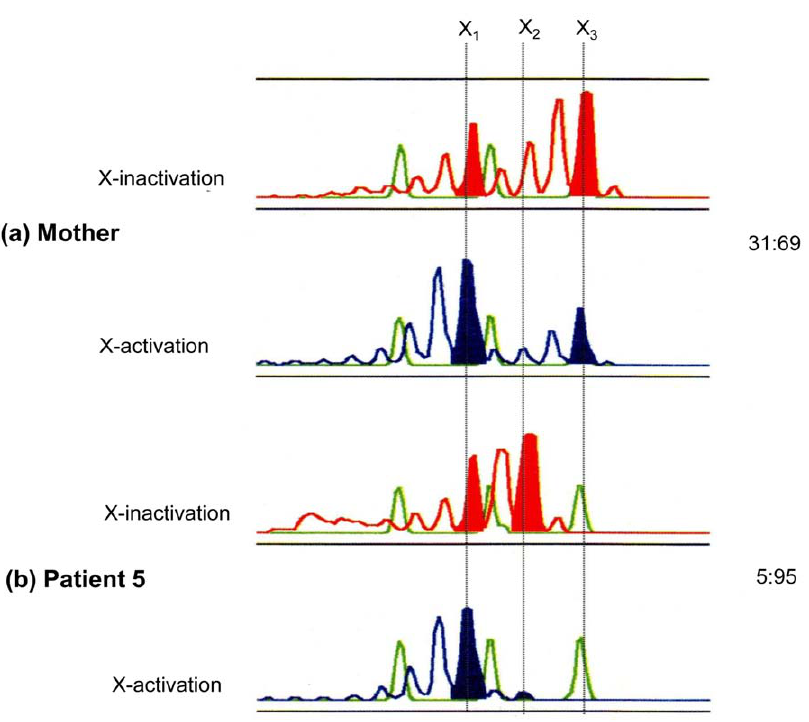
Figure 6. The Results of an Analysis of X-Chromosome Inactivation and Activation Patterns in the Chronic Granulomatous Disease Sufferer Patient 5 and Her Mother. The female infant had inherited an abnormal (with deletion) X-chromosome X1 from the mother and a normal X-chromosome X2 from the father. A random inactivation pattern of 69:31 was observed in the mother (carrier). In the female patient, however, a markedly skewed X-chromosome inactivation pattern of 95:5 (with activation of the X-chromosome with gene deletions transmitted from the mother and inactivation of the X-chromosome with the normal genes transmitted from the father) was observed.